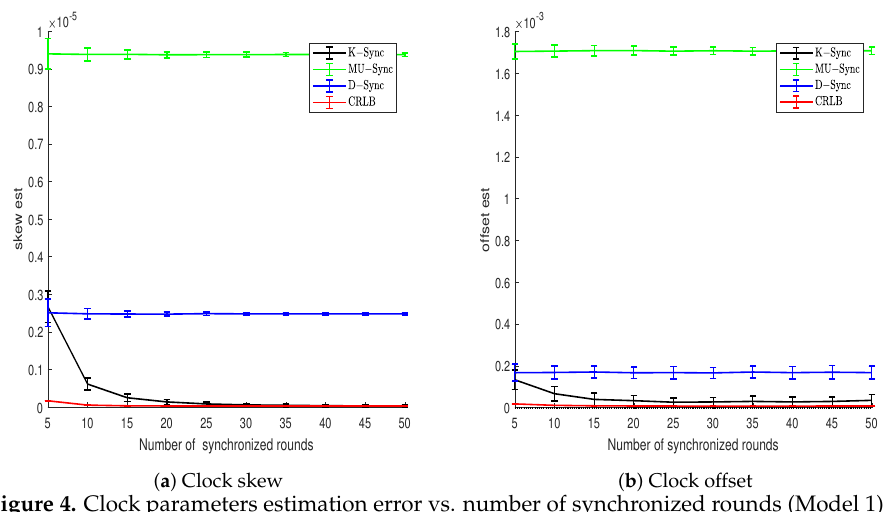
Figure 4. Clock parameters estimation error vs. number of synchronized rounds (Model 1).